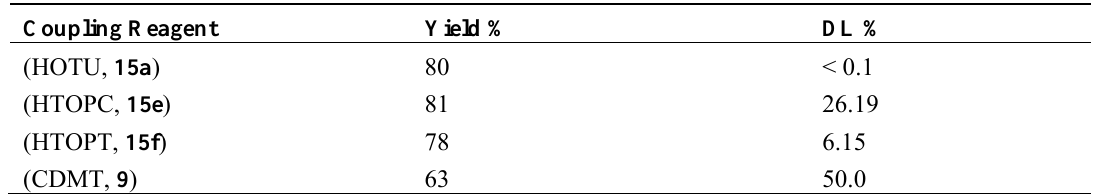
Table 4. Yield (%) and Racemization of (%) Z -Gly-Phe-Val-OMe ( 17b ) using the Uronium Salts 15a,e,f and CDMT ( 9 ).*